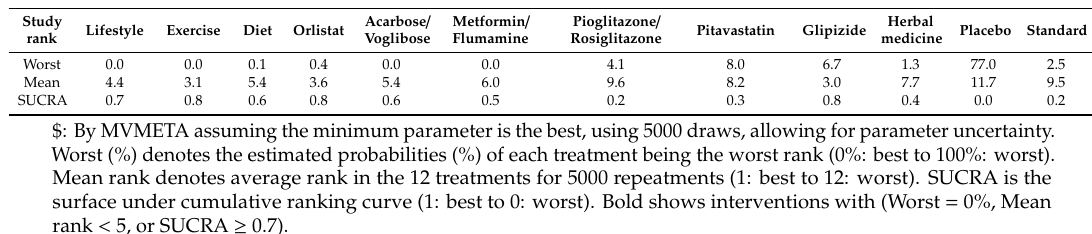
Table 2. Surface under the cumulative ranking curve (SUCRA) by NMA $